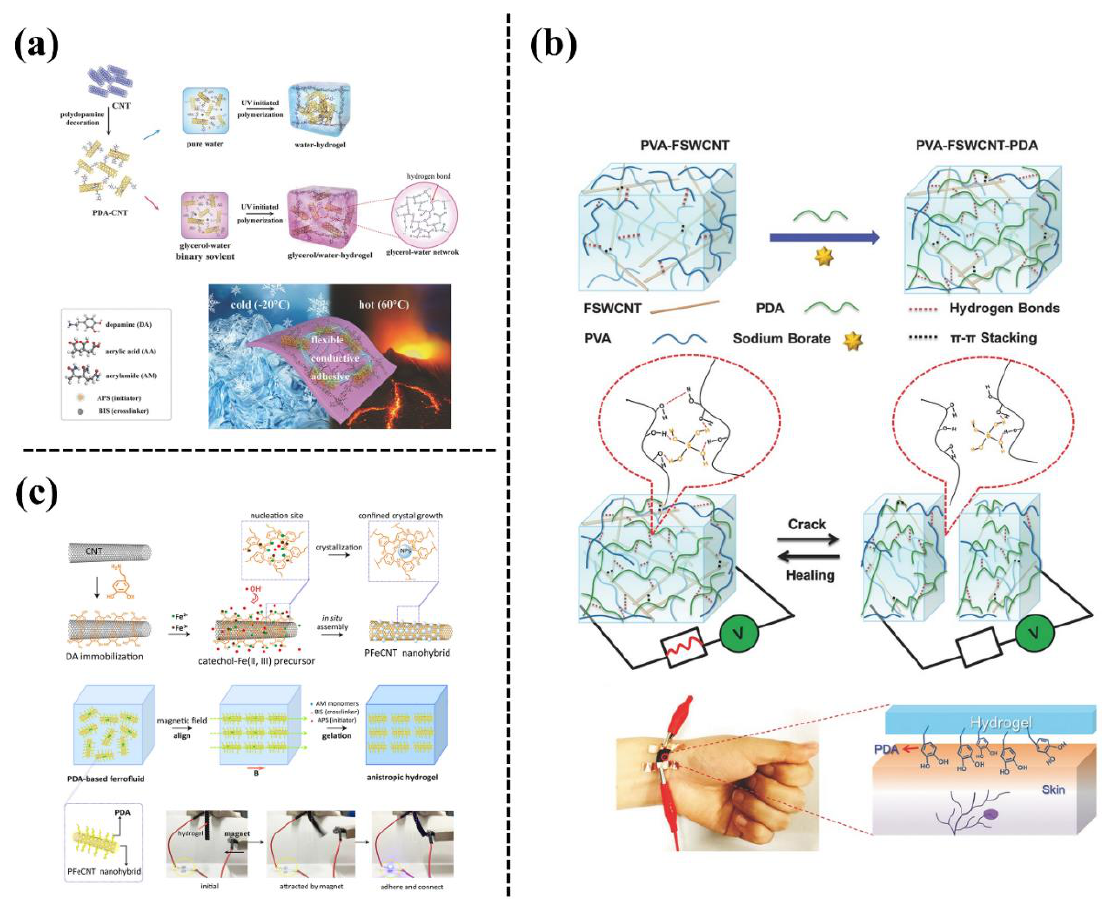
Figure 11. ( a ) Fabrication of a mussel-inspired conductive, adhesive, and anti-freezing/anti-heating hydrogel by co-polymerization of PDA-modified CNTs with AA and AM in a glycerol-water (GW) binary solvent [76]. ( b ) Schematic diagram of the synthesis process of a conductive, healable, and adhesive hydrogel by incorporation of a conductive PDA-functionalized SWCNTs nanotube into a dynamic supramolecular crosslinked PVA hydrogel, which can be adhered on the wrist for healthcare monitoring [77]. ( c ) Schematic of preparation of an anisotropic hydrogel based on a mussel-inspired conductive ferrofluid comprised of PDA-mediated conductive and magnetic Fe 3 O 4 -CNT nanohy- brid (PFeCNT). Demonstration of the anisotropic hydrogel simultaneously possessing conductive, magnetic, and self-adhesive properties